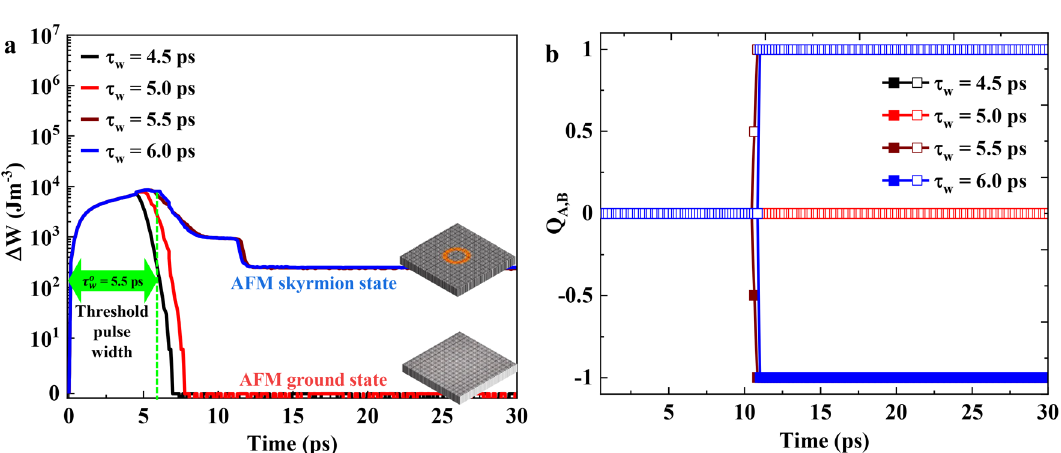
Figure 1. ( a ) Snapshots during nucleation of AFM skyrmion at different instants of time when a current pulse 5.5 ps is applied. Here, (green/red) circle represent current pulses (ON/OFF). The current is with a width τ w = 70 nm. The final diameter of the AFM skyrmion is found to injected in a circular region with diameter, d n = 32 nm after 20 ps. ( b ) The evolution of topological charge Q A for sublattice A (open symbols) and Q B of be d s = sublattice B (closed symbols) during the nucleation of the AFM skyrmion.